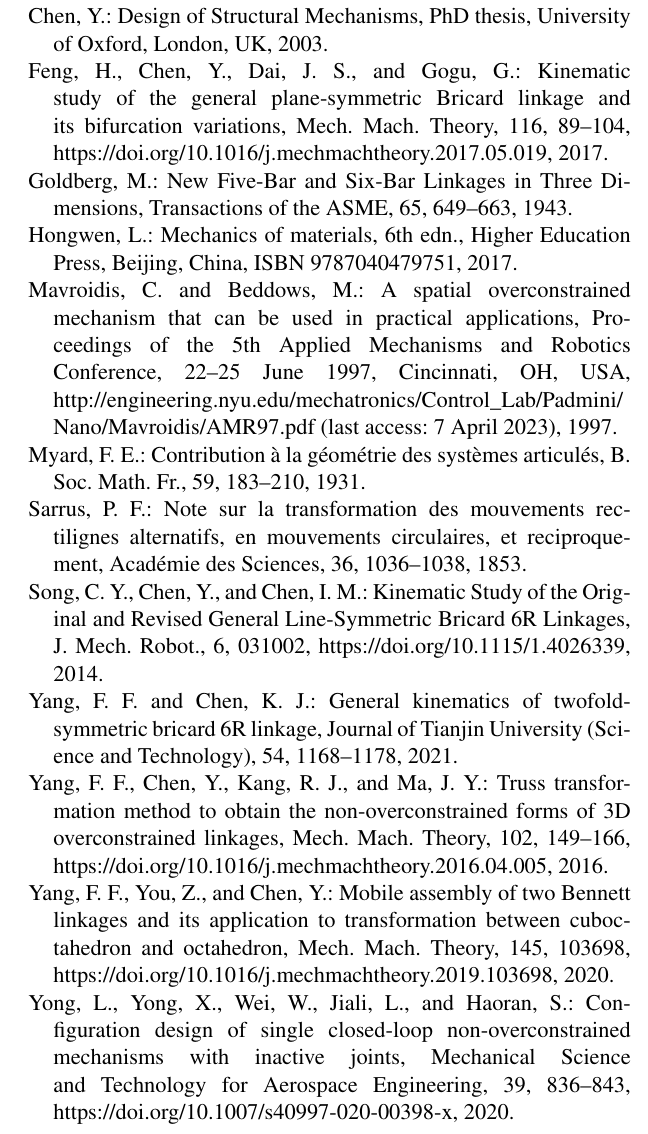
figuration design of single closed-loop non-overconstrained